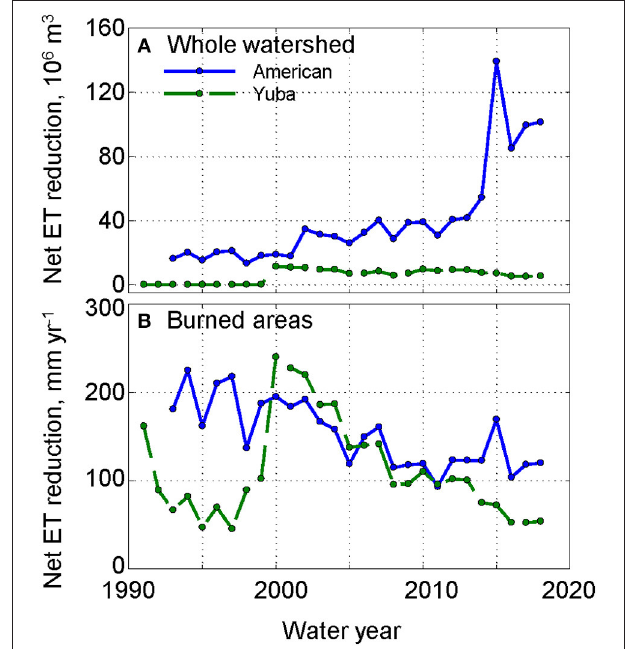
FIGURE 7 | Change in evapotranspiration (ET): (A) net whole-basin volumetric change and (B) depth of ET reduction in burned areas (1990–2017) for each